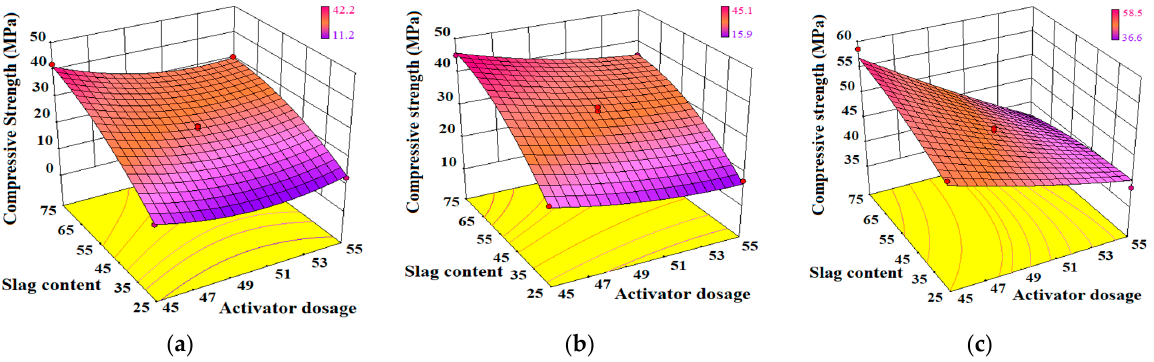
Figure 12. Effect of interaction between W SG and M on the compressive strength model of AA-FASM. ( a ) 1 day. ( b ) 3 days. ( c ) 28 days. (2) Interaction of W SG /R A